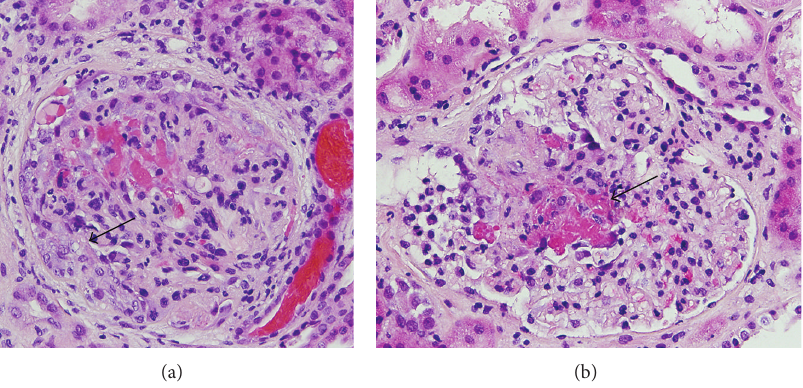
Figure 1: Kidney biopsy. (a) Glomerulus showing cellular crescent (arrow) with proliferation of visceral and parietal epithelial cells (H&E stain). (b) Glomerulus with segmental necrosis with disruption of the basement membrane, nuclear fragments, and fibrin deposition